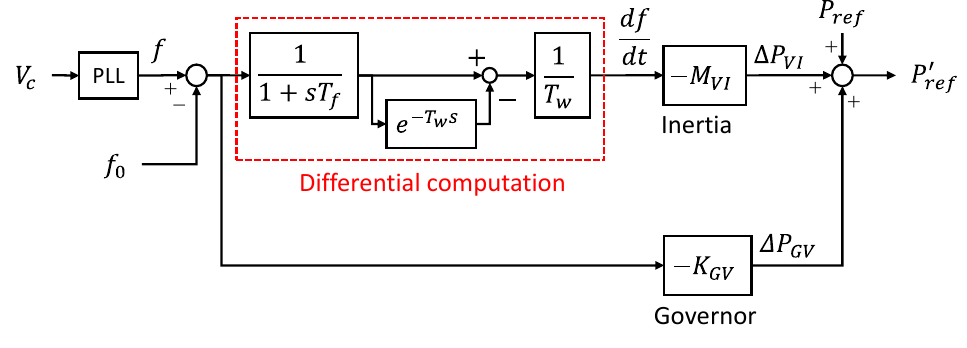
Figure 6. Controller model of the VI-GFL.